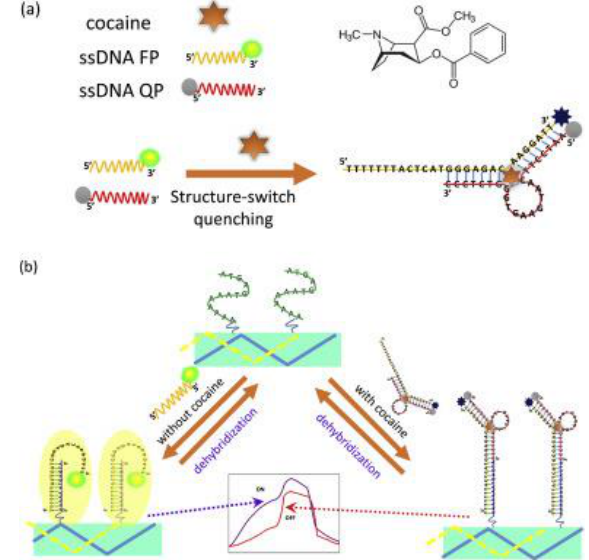
Figure 5. Schematic of cocaine sensing based on structure switching optical biosensing platform. ( a ) Structure switching of cocaine combining the two aptamer fragments; ( b ) hybridization and regeneration of the aptamer with optical fiber. Reproduced with the permission of [119]. Copyright 2016 Published by Elsevier B.V.